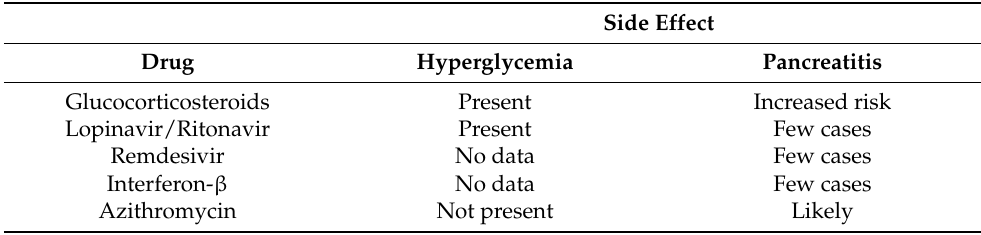
Table 2. Side effects of medications used in SARS-CoV-2 infection in the area of pancreatic effects and hyperglycemia. Side Effect Drug Hyperglycemia Pancreatitis Glucocorticosteroids Present Increased risk Lopinavir/Ritonavir Present Few cases Remdesivir No data Few cases Interferon- β No data Few cases Azithromycin Not present